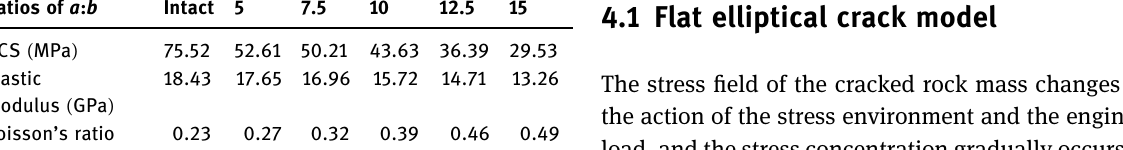
Table 3: Physical parameters of six numerical models Ratios of a : b